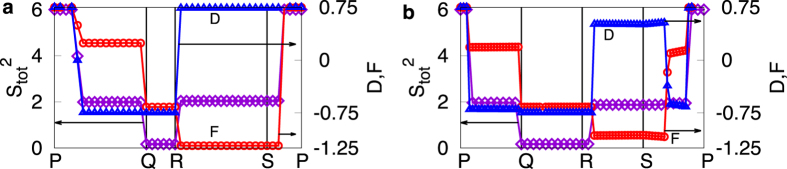
Change in total spin (violet diamonds), spin-spin correlations, D = ∑ijDij (blue triangles), and spin-fermion correlations, F = ∑ijFij (red circles) for (a) JAF = 0.2 and (b) JAF = 1.0, upon varying parameters along the path shown in Fig. 2(c,d), respectively.